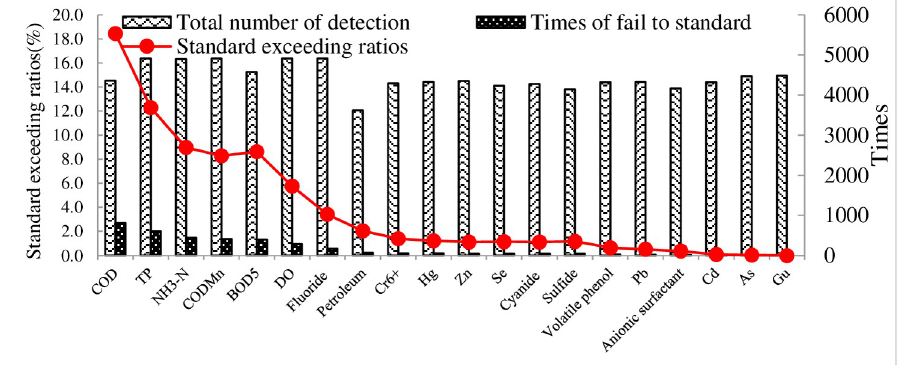
Fig 5. Monitoring frequency, and exceeding rates of each